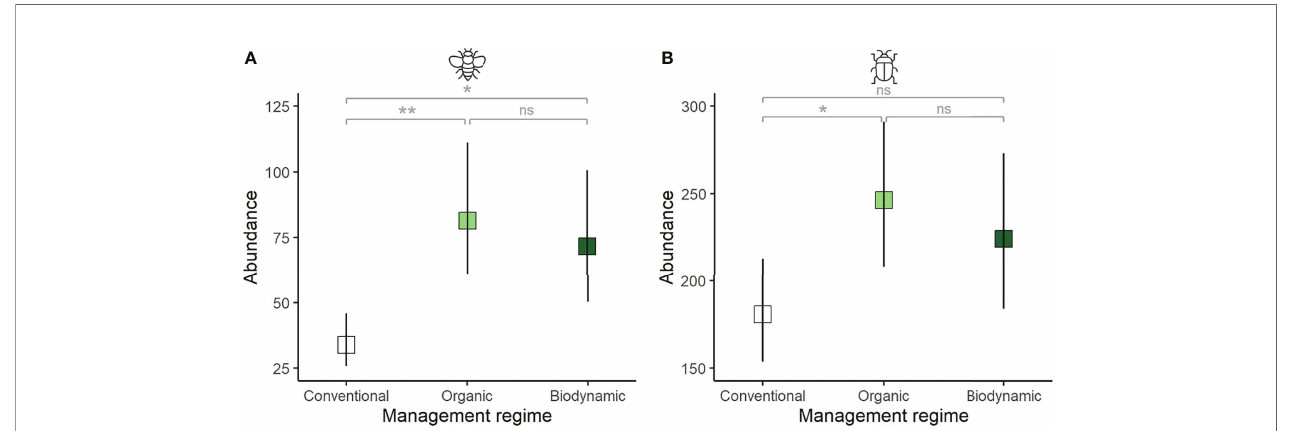
FIGURE 2 | Differences in invertebrate abundance from (A) sweep net (represented by dipterans) and (B) pitfall trap samples (represented by beetles) with respect to management regime. Plotted are the model-based predictions, where boxes show mean estimates and vertical lines the 95% con fi dence intervals. Stars indicate